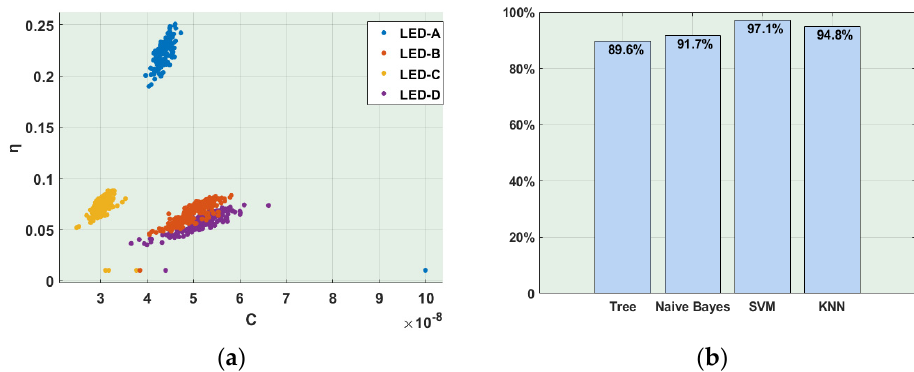
Figure 6. ( a ) Extracted LED fingerprints; ( b ) Comparison of verification accuracy.